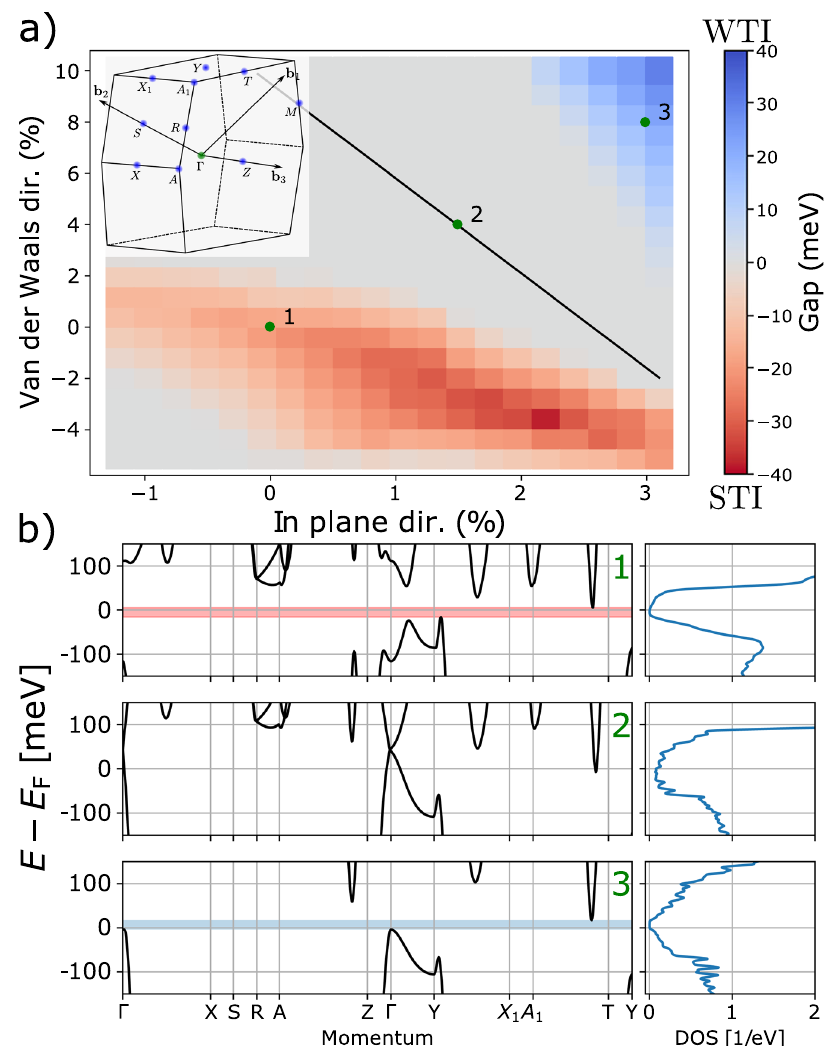
Fig. 4 Topological phase diagram of ZrTe 5 . a The phase diagram of the electronic structure of the crystal under mechanical strain. At every point the size of the gap was calculated and a sign has been assigned to it according to the topological fl avor of the gap. The negative gap corresponds to the strong topological insulating phase, while the positive gap to the weak topological phase. The black solid tentative line indicates the boundary where the Dirac cones in the Γ point touch each other. The green dots assigned with a number denote the corresponding band structure in the b sub fi gure. The inset shows the corresponding Brillouin zone indicating the high-symmetry points. b The calculated band structure along the path of the high-symmetry points. The opaque band shows the size of the gap and color indicates the topological fl